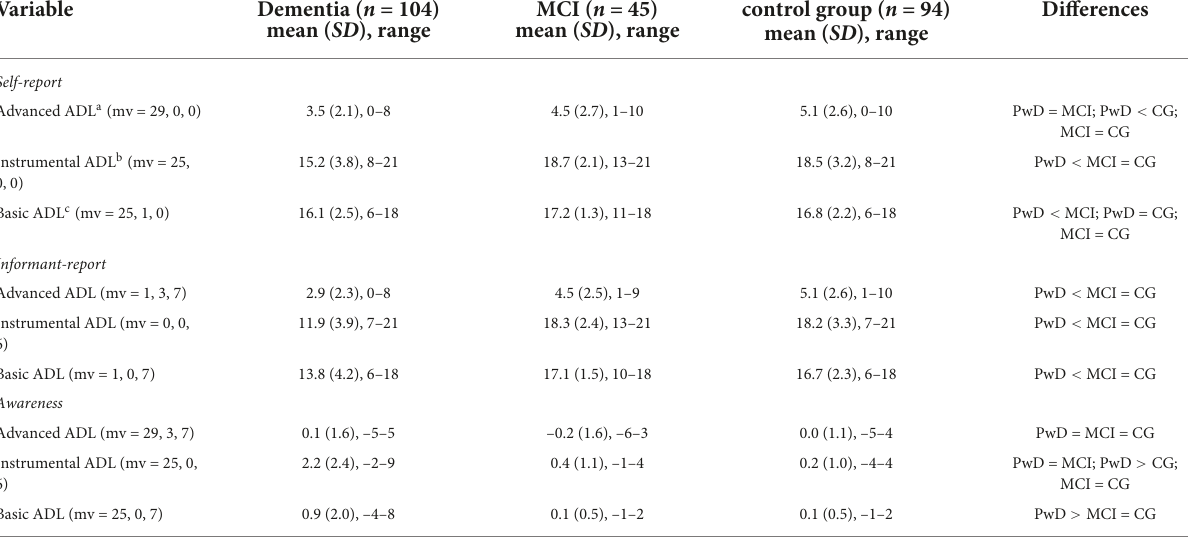
TABLE 2 Activities of daily living performance and awareness divided by